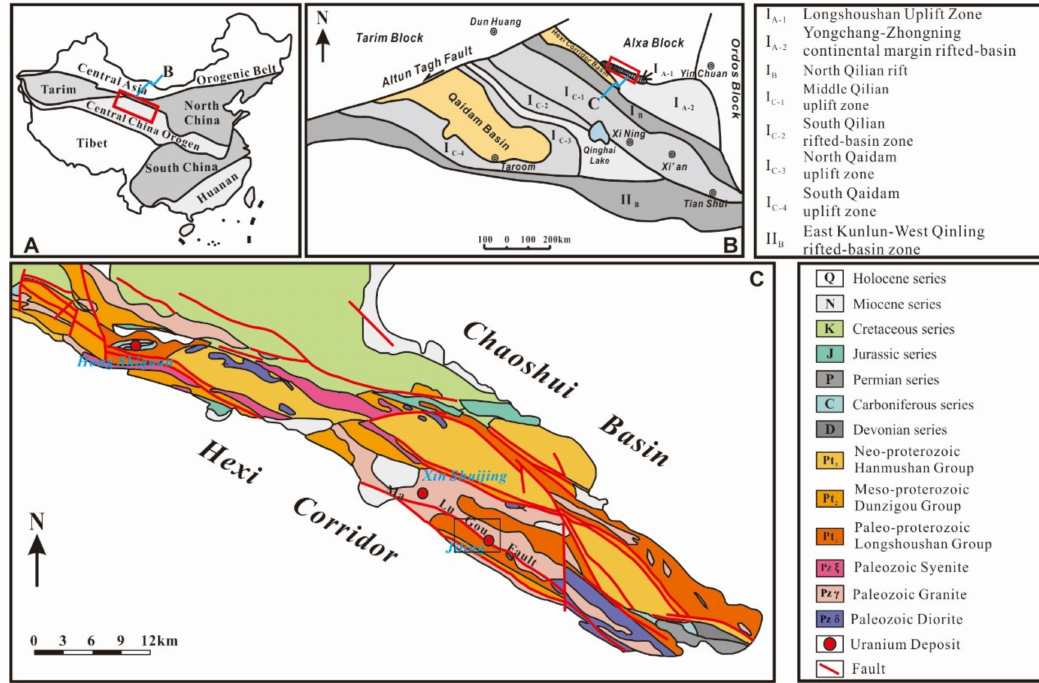
Figure 1. ( A ) The main geotectonic units of China with the location of the Longshoushan Metallogenic Belt (LMB). ( B ) A geological map of northwest China showing the main tectonic units (modified after [41]. ( C ) A regional geological map of Longshoushan Metallogenic Belt (LMB), showing the locations of the two sodium metasomatic type deposits (the Jiling and Xinshuijing uranium deposits) and pegmatite uranium deposit (Hongshiquan uranium deposit) (modified after